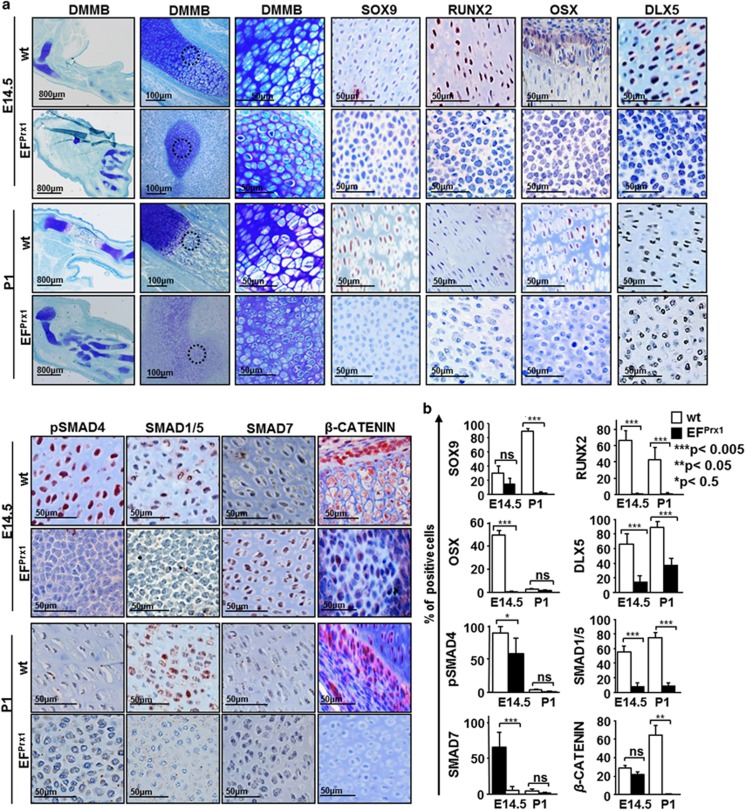
Blocked bone signaling pathways upon EF expression. (a and b) Dimethylmethylene blue (DMMB) as a chondrocyte marker showed marked reduction of Glycosaminoglycan in mutant embryos. IHC staining analysis on consecutive embryo sections of E14.5 and postnatal day P1 mice showed that EF expression in limb mesenchyme promotes downregulation of TGF-β signaling pathway. Black circles indicating the magnified region showing in the next column. (b) Quantification of IHC signals from (a). At least three different independent embryos for every single staining and for each time point were carried out. Quantitation was done by (ANOVA) one-way analysis of variance. *P<0.5, **P<0.05 and ***P<0.005